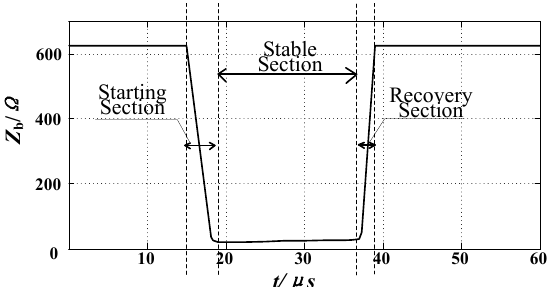
Figure 7. Impedance curve during the bearing breakdown process.